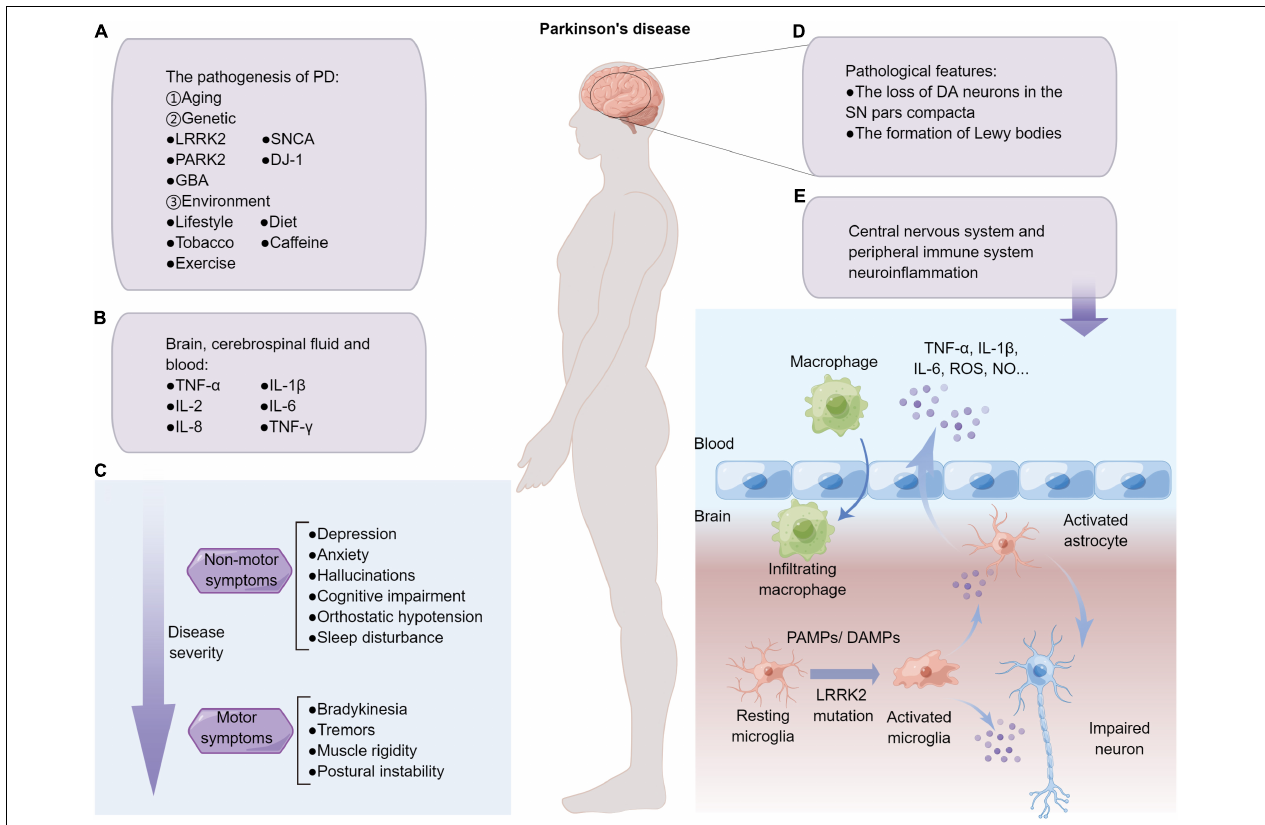
FIGURE 1 | Overview of PD and neuroinflammation. (A) The pathogenesis factors of PD mainly include aging, genetic and environmental factors. (B) PD is a disease of systemic inflammation with pro-inflammatory factors that have been detected in the human brain slices, cerebrospinal, and blood. (C) Patients with PD often present with non-motor symptoms, which often precedes the development of motor symptoms. (D) Two major pathological features of Parkinson’s patients. (E) PAMPs/DAMPs stimulation, as well as PD-related gene mutation such as LRRK2 G 2019 S , promote resting microglia skewing into pro-inflammatory phenotypes, which secrete excessive pro-inflammatory factors that may damage neurons and activate astrocytes in the milieu. The damaged blood-brain barrier of PD patients further causes neuroinflammation to diffuse in the CNS and peripheral system, and develop from acute inflammation to systemic chronic